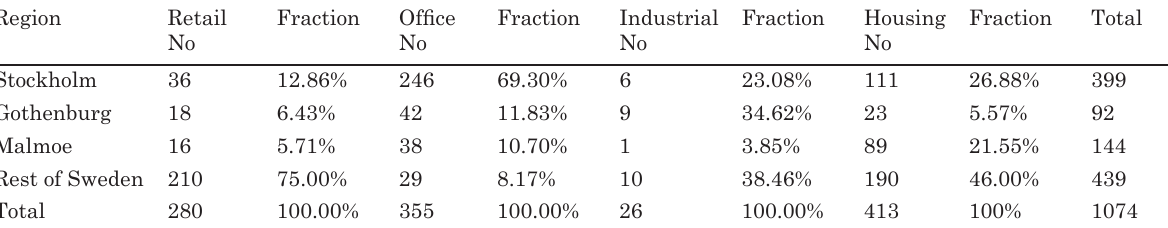
Table 2. Geographical distribution of the property types